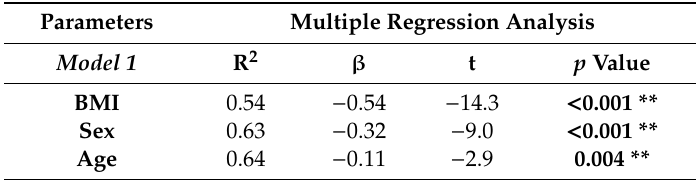
Table 5. Multiple regression analysis models (stepwise method) with PhA as dependent variable to estimate the predictive value of: BMI, sex, and age.